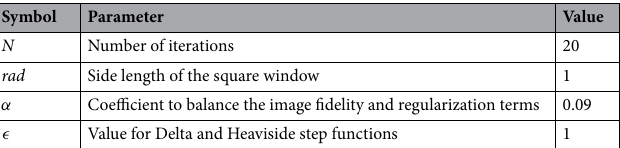
Table 1. Parameter setting for the localized active contour segmentation employed in mean separation (MS)